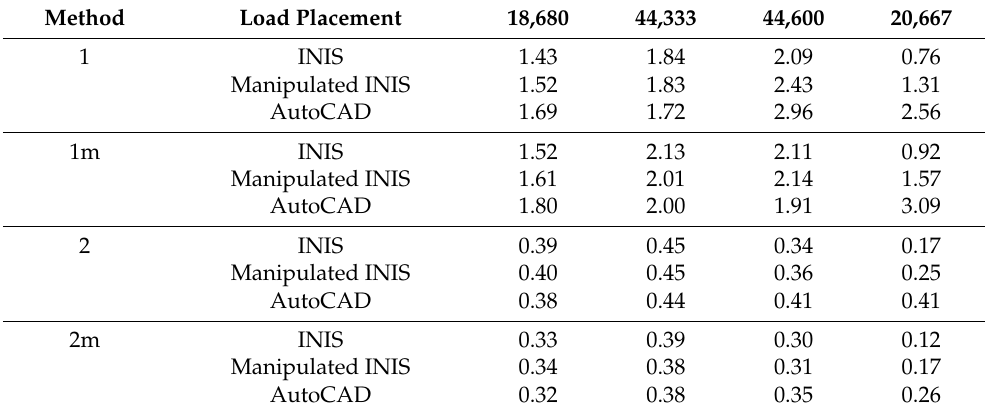
Table 3. Temporal and spatial averages of the relative errors of the scenarios.